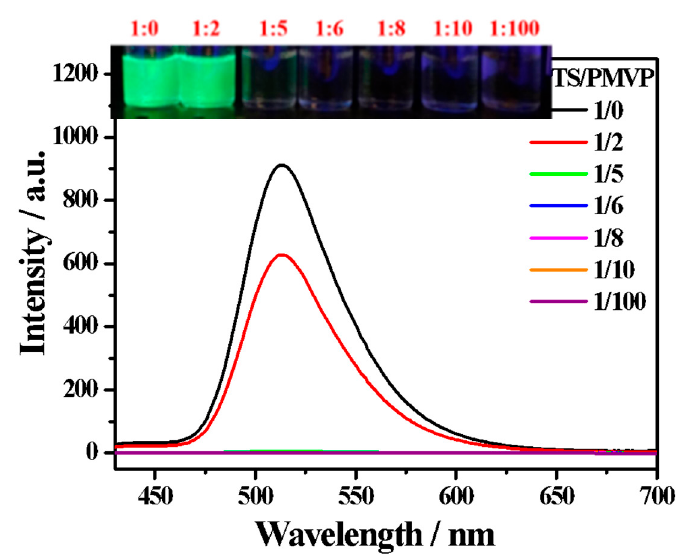
Figure 2. Fluorescence spectra of HPTS (0.01 mM) in water at different charge ratios of HPTS: PMVP. Excitation wavelength: 405 nm. Inset shows that the complex emission color with different charge ratios of HPTS:PMVP changes under a UV (365 nm) lamp. PMVP is the abbreviation of PMVP 41 - b -PEO 205 .